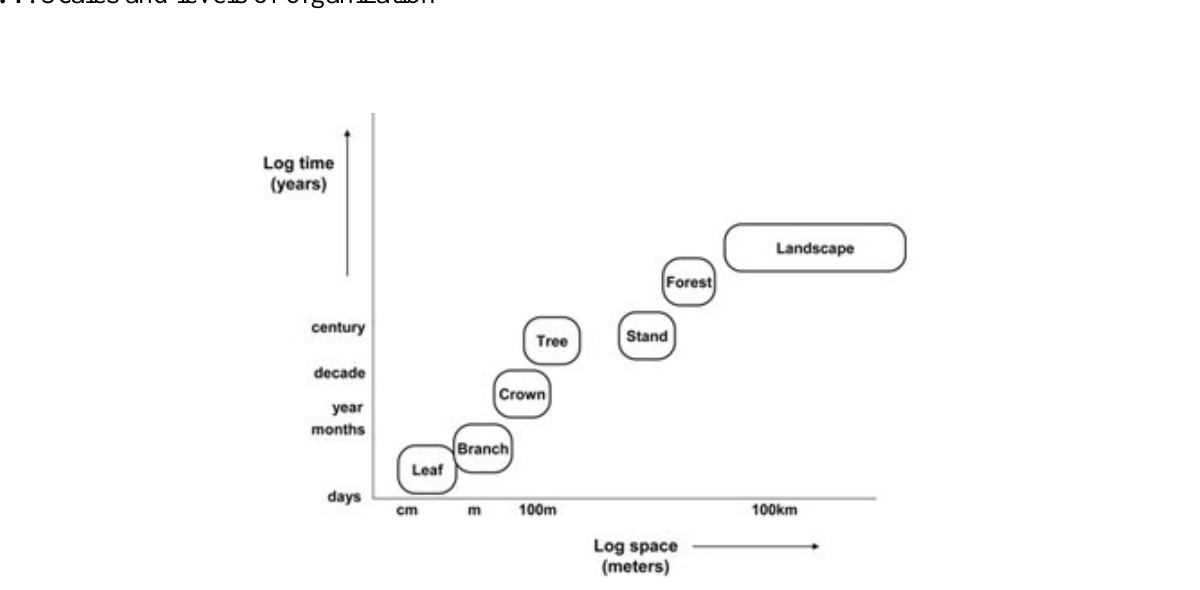
Fig. 1 . Scales and levels of